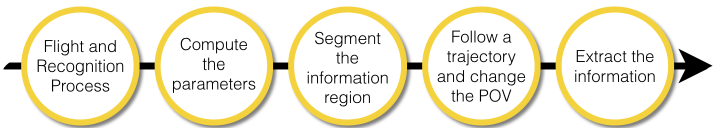
Figure 13. Methodology to build a 3D map of the material inside the trailer during a loading process using a forage